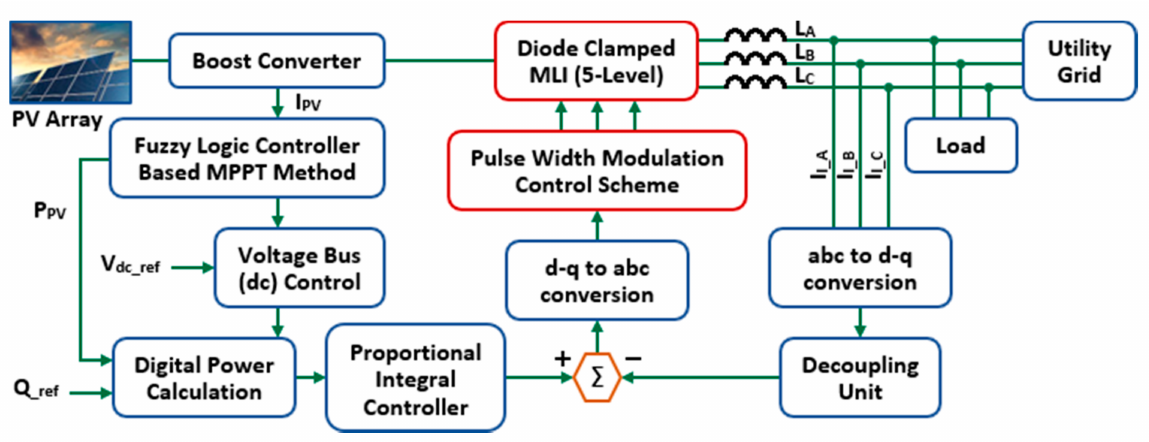
Figure 28. Block diagram of grid tied PV system with digital proportional integral control and fuzzy logic